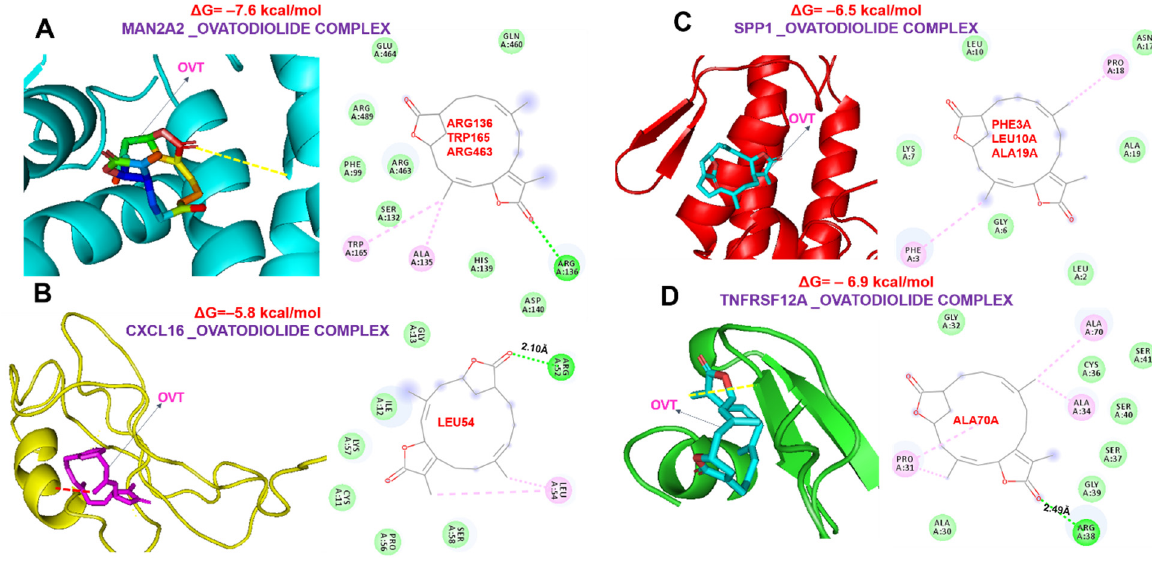
Figure 8. Three- (3D) and two-dimensional (2D) representations of ligand–receptor complexes, showing interacting amino acid residues and the types of interactions occurring between ovatodiolide and ( A ) MAN2A2, ( B ) CXCL16, ( C ) SPP1, and ( D ) TNFRSF12A.